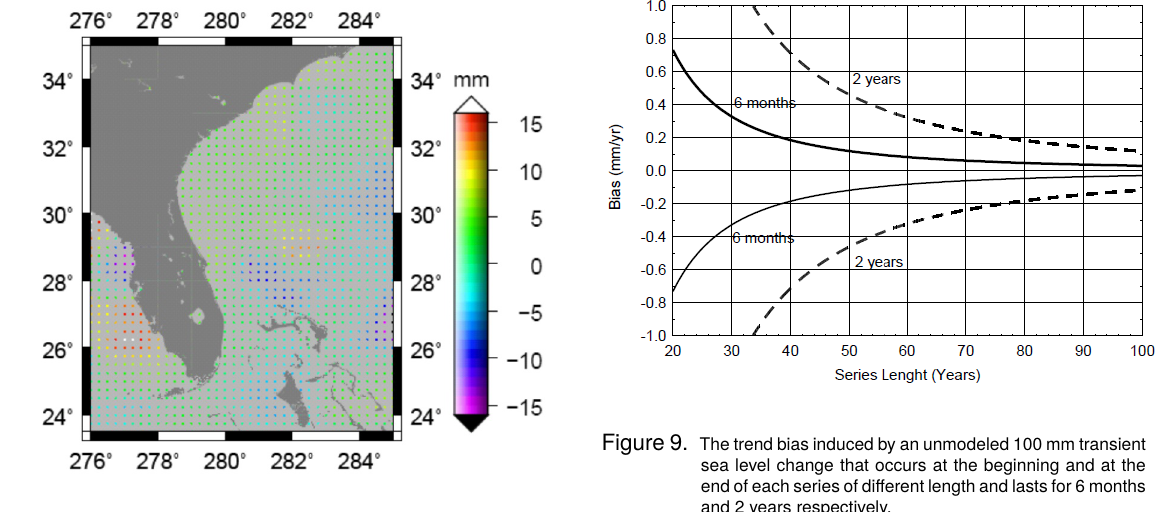
Figure 8. MSL trends (mm/yr) using multiple satellite altimetry data ( ∼ 20 yr).